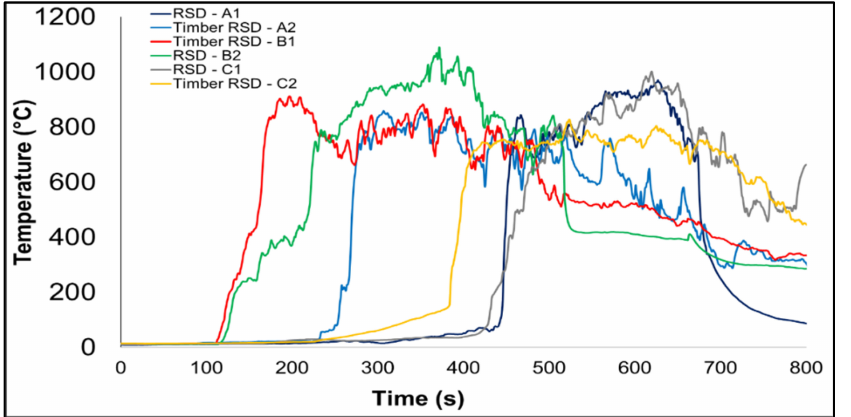
Figure 20. Ceiling temperature of each RSD in test setup